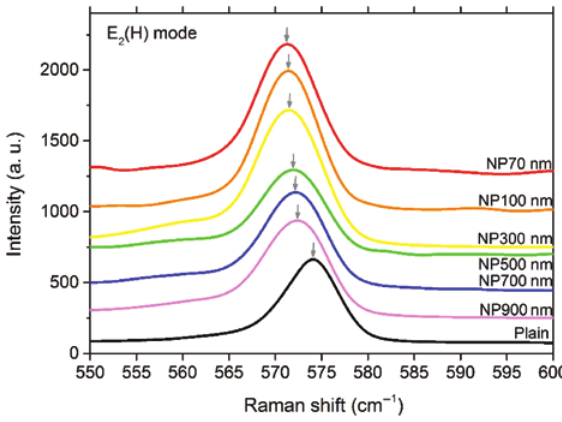
(H) phonon mode of different 2